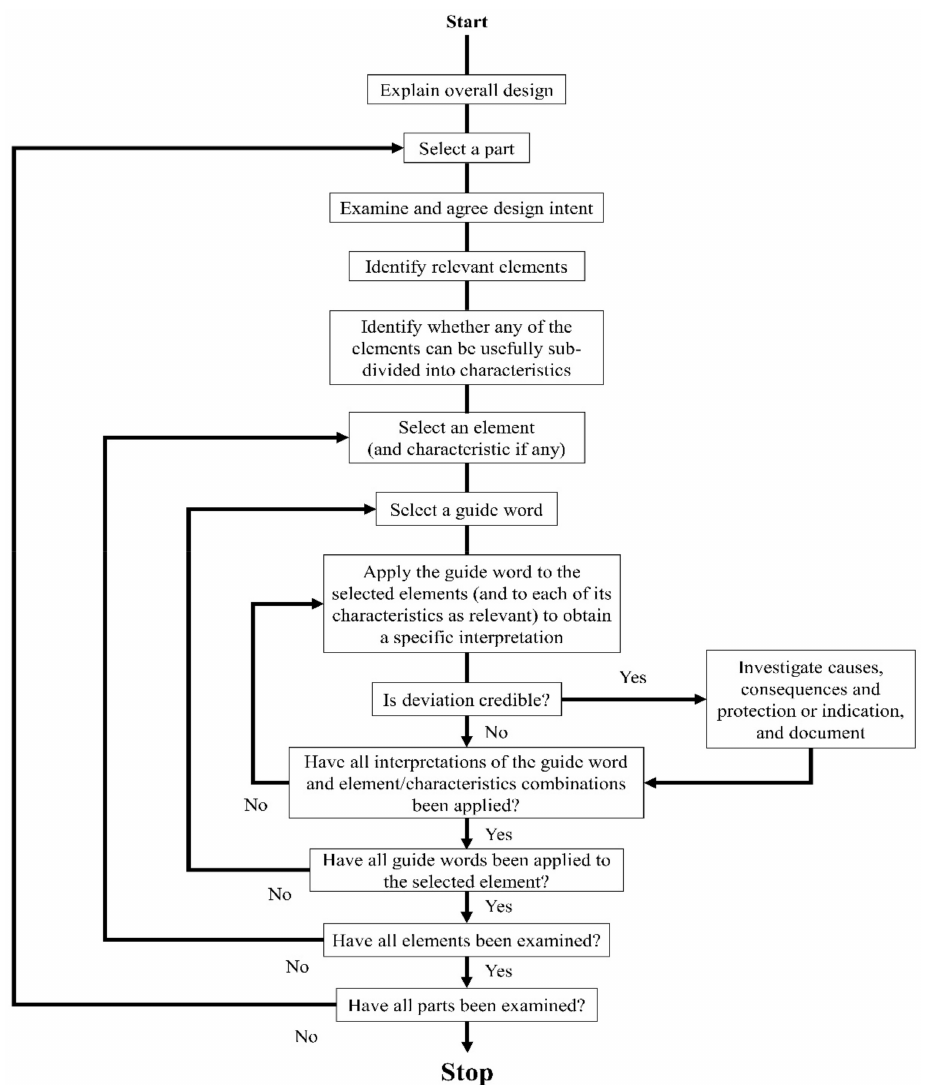
Figure 1. Flowchart of the HAZOP examination